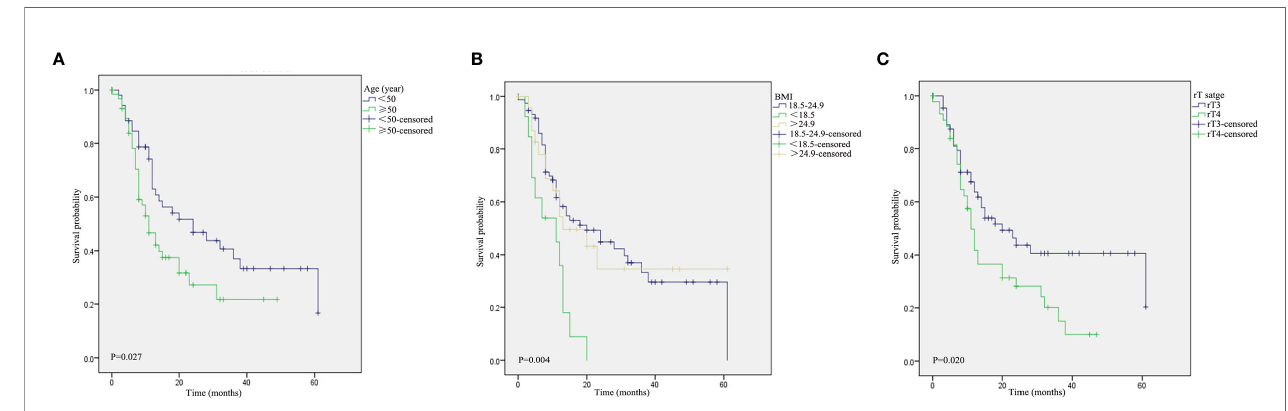
FIGURE 5 | Kaplan – Meier curves pertaining to the progression-free survival in patients with recurrent nasopharyngeal carcinoma: (A) age ( ≥ 50 vs . <50 years); (B) body mass index (BMI); and (C) rT stage (rT3 vs TABLE 4 | Univariate and multivariate Cox regression analyses of OS in patients with rNPC. Variable